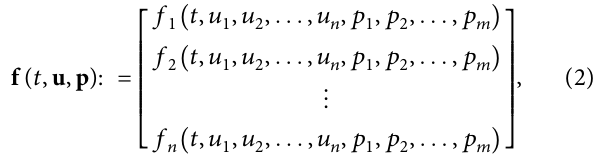
algorithm for parameter estimation; (5) numerical experi- ments; and (6) conclusions and further